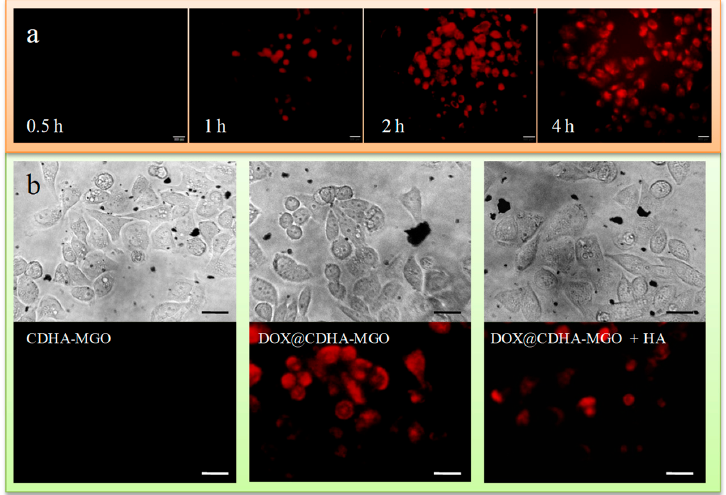
Figure 6. ( a ) Photomicrographs of BEL ‐ 7402 cells treated with DOX@CDHA–MGO (20 μ g ∙ mL − 1 ) at 37 °C for incubation times of 0.5, 1, 2, and 4 h, observed under an inverted fluorescence microscope. ( b ) Fluorescence microscopy images of BEL ‐ 7402 cells incubated for 2 h at 37 °C with CDHA–MGO and DOX@CDHA–MGO in the presence or absence of free HA. Scale bar = 20 µ m.